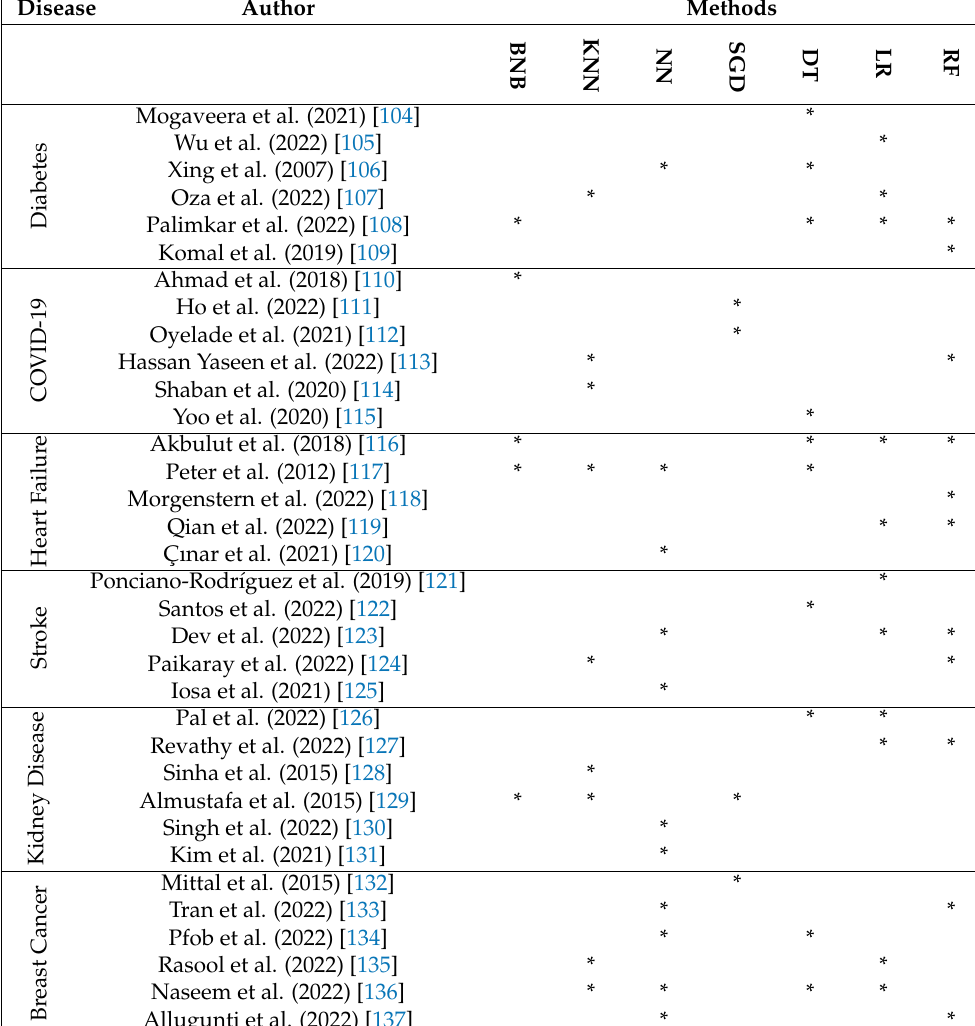
Table 16. List of existing research works based on diseases and algorithms (annotated with *) used for their